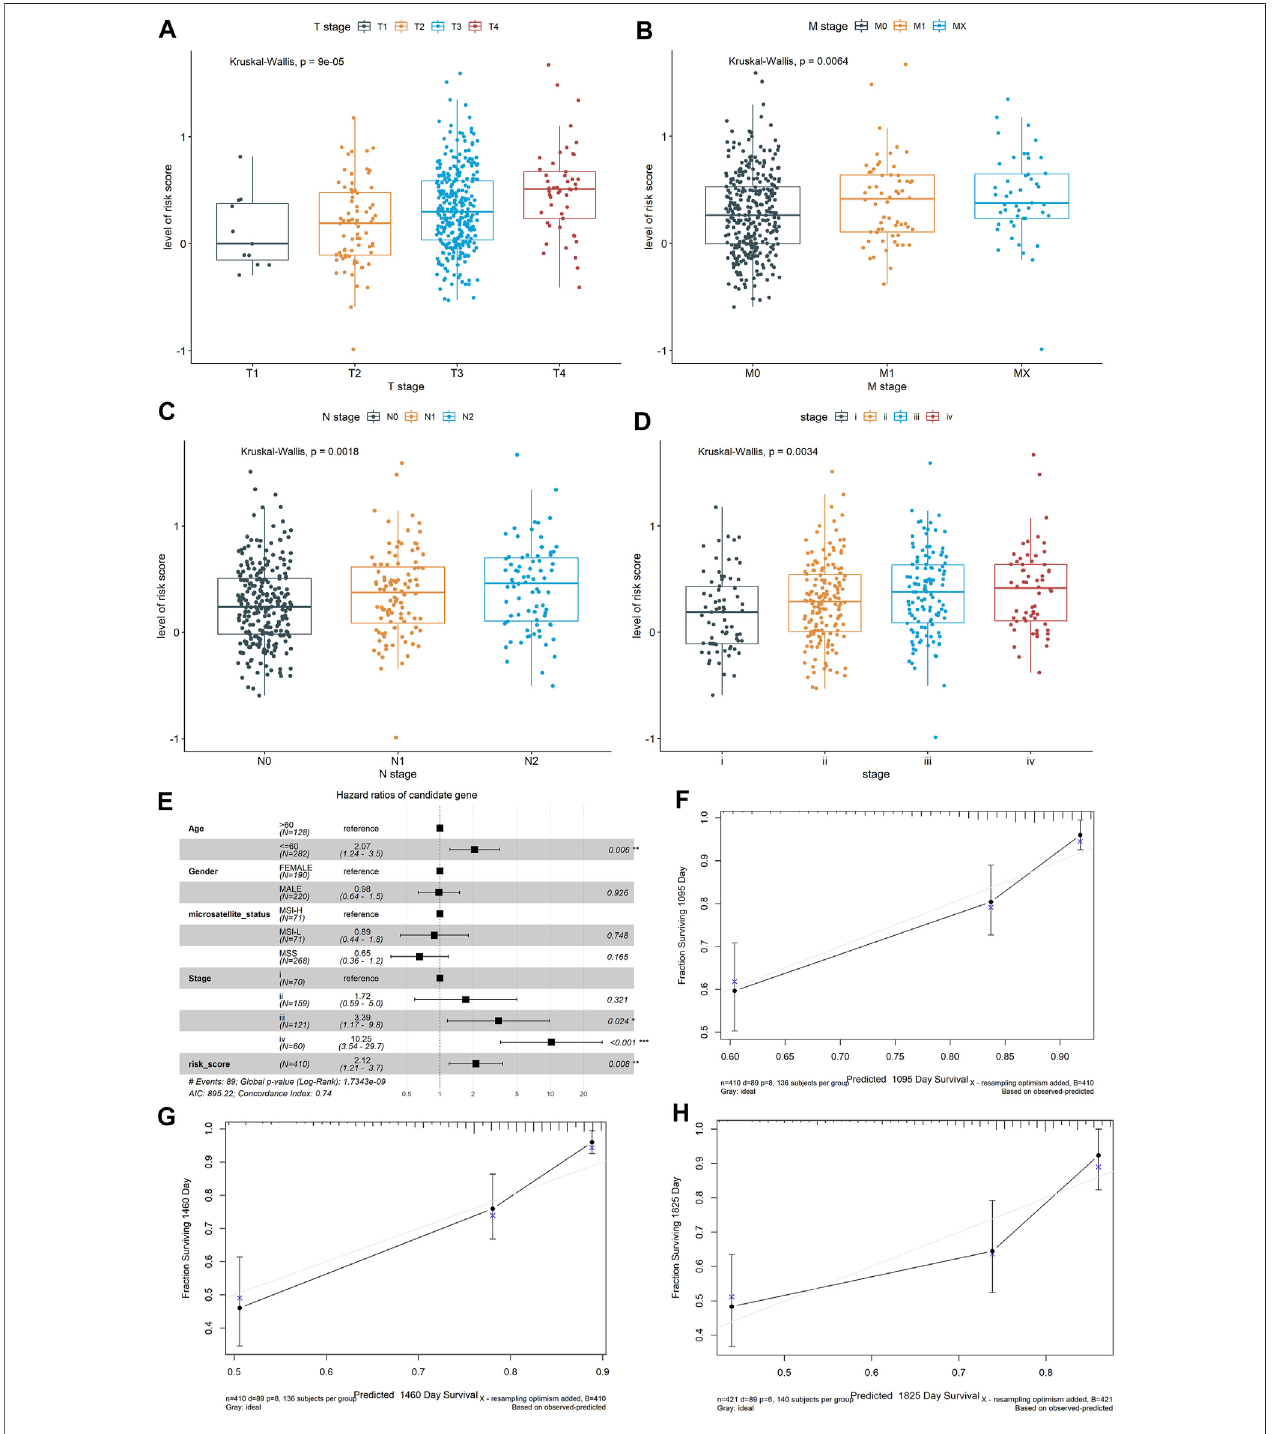
FIGURE 3 | Exploring the relationship between the risk score of the colon cancer patients and clinical and pathological characteristics, including (A) T stages, (B) M stages, (C) N stages, and (D) advanced pathological stages, based on the whole dataset. Construction and validation of a nomogram. (E) Forest plots showed theassociations between patients ’ characteristics and OS. (F – H) The calibration plot ofthenomogram to predict the probability of OS at 3, 4, and 5 years.